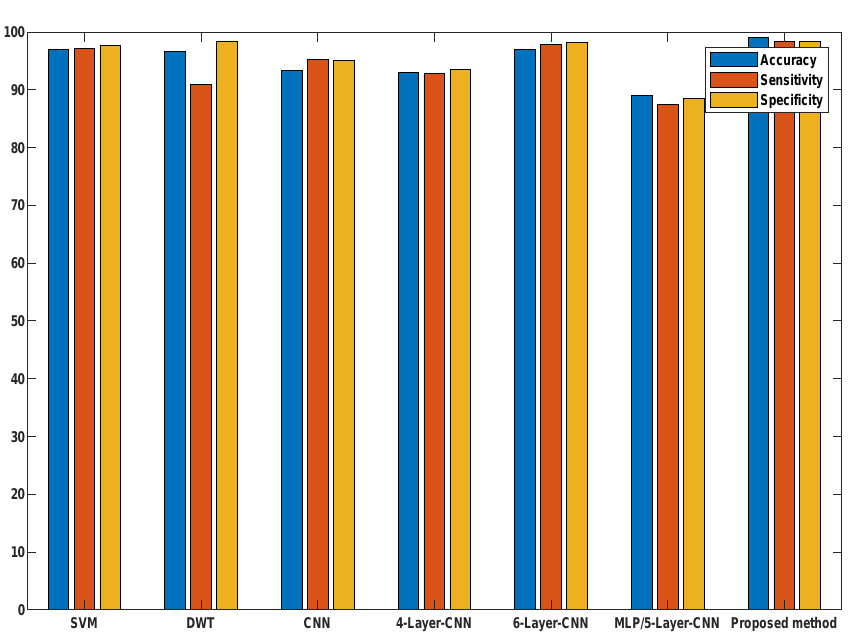
Figure 15. Comparative analysis of the proposed model with the existing sate-of-the-art